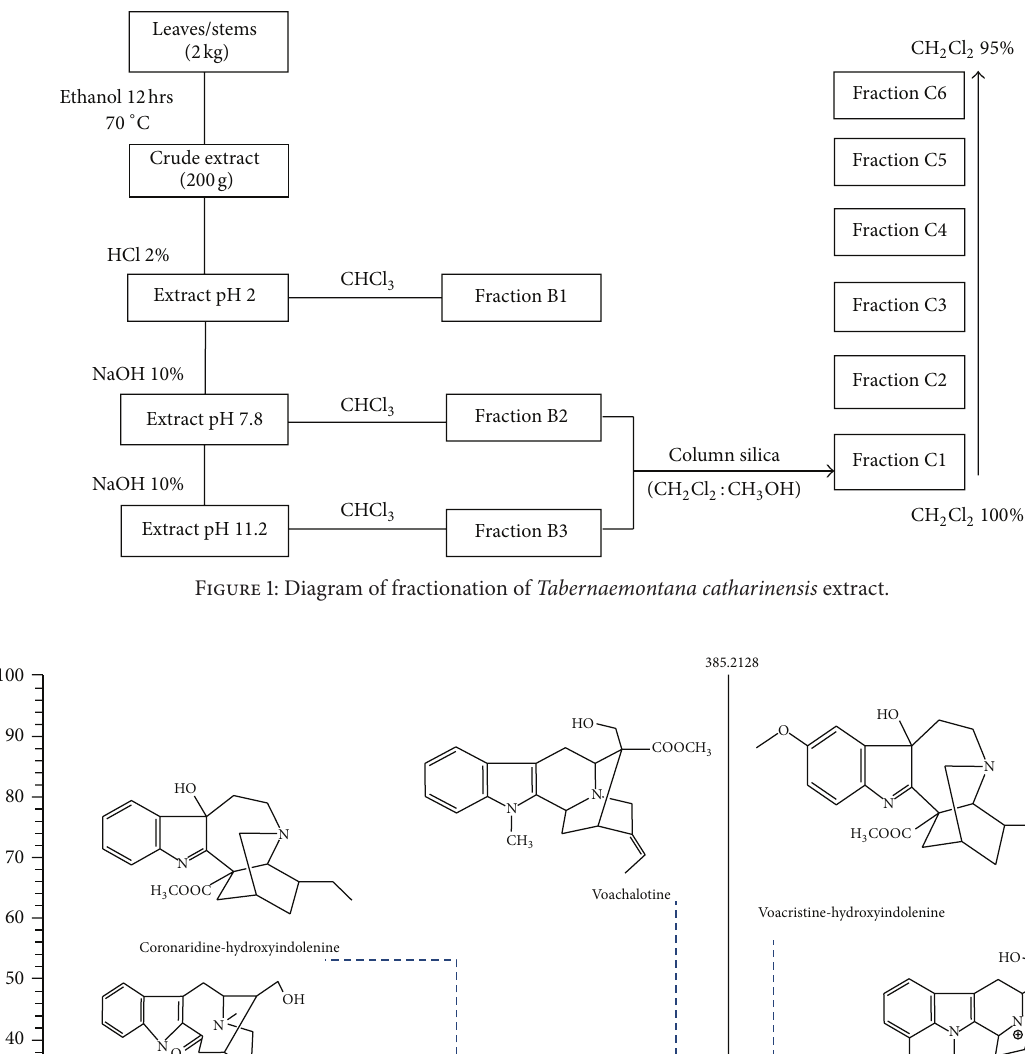
using SPSS16.0 software for Windows (SPSS Inc., Chicago, IL,